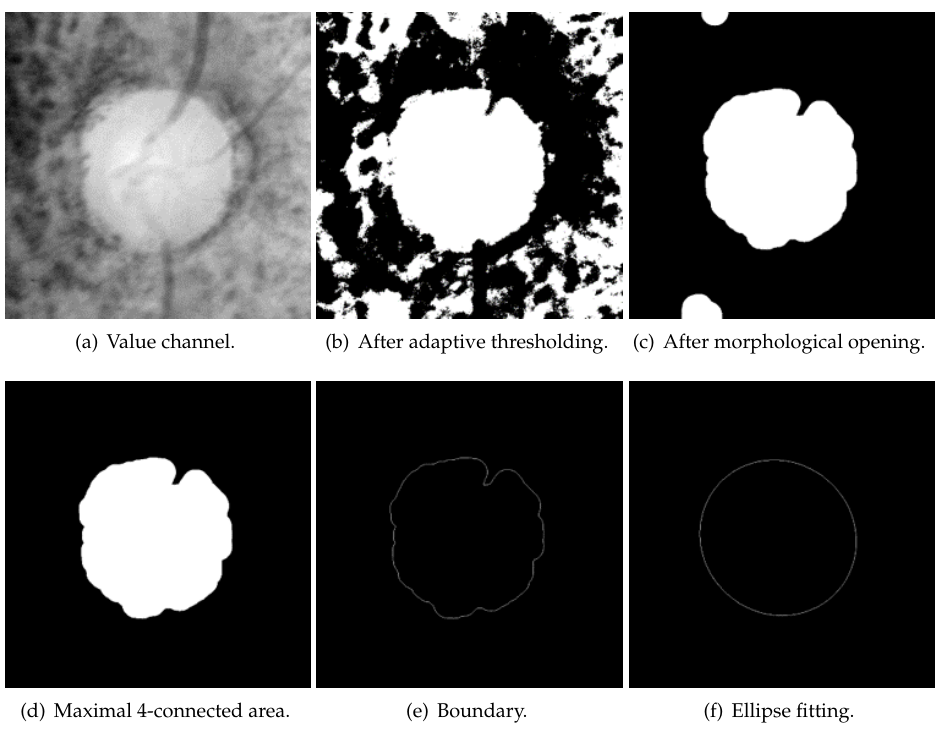
Figure 17. The results of initial-value